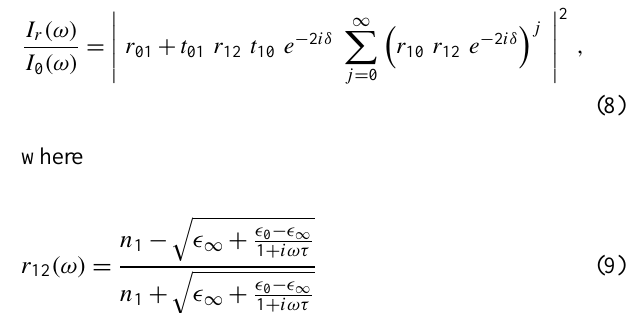
PMMA, PMP and HDPE (each d = 20 mm thick) to the